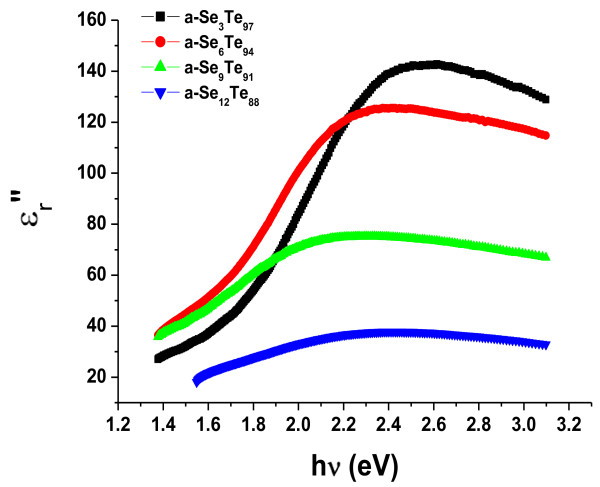
Variation of dielectric constant imaginary part with incident photon energy in a-SexTe100-xaligned nanorod thin films. Єr″, imaginary part of the dielectric constant; hν, incident photon energy.